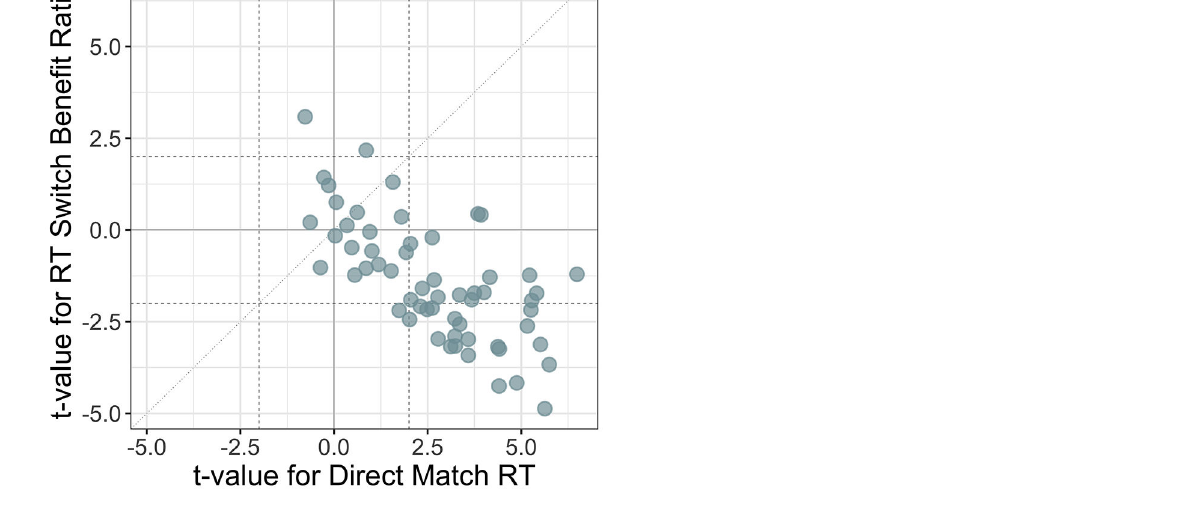
Note. Scatterplot of individual participants’ t -values for predicting missing-operand problem RTs from the direct arithmetic match RT ( x -axis) and the switch benefit (ratio of direct over inverse arithmetic match RTs; y -axis). Horizontal and vertical dashed lines indicate cutoffs for statistical significance, and the diagonal line represents identity between t